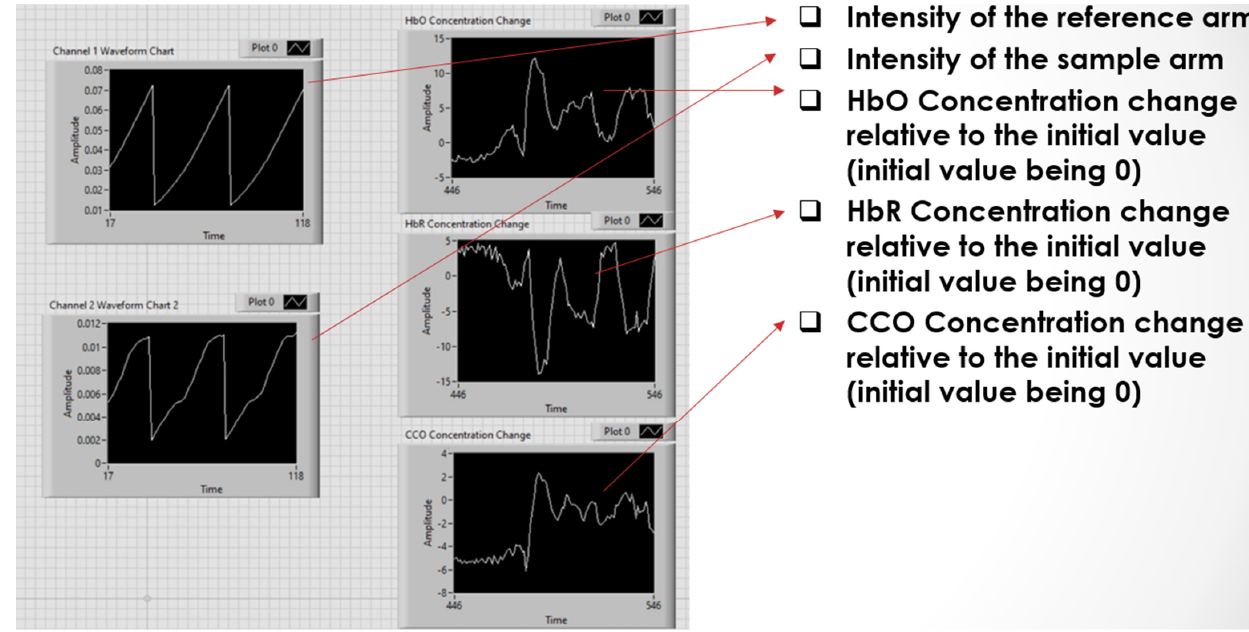
Figure 31. GUI display of data collected by SCISCCO.